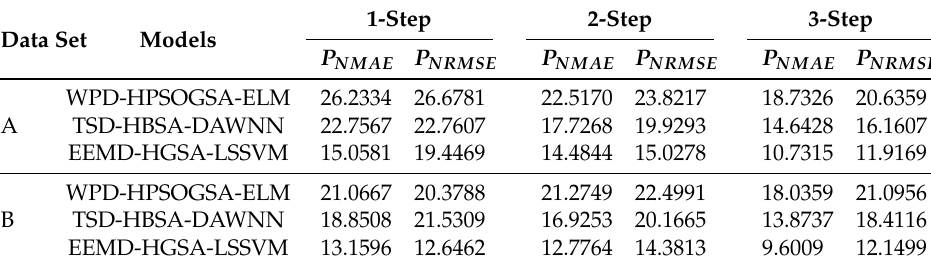
Table 8. Improved indexes P NMAE and P NRMSE of the recently developed forecasting models compared with the proposed model